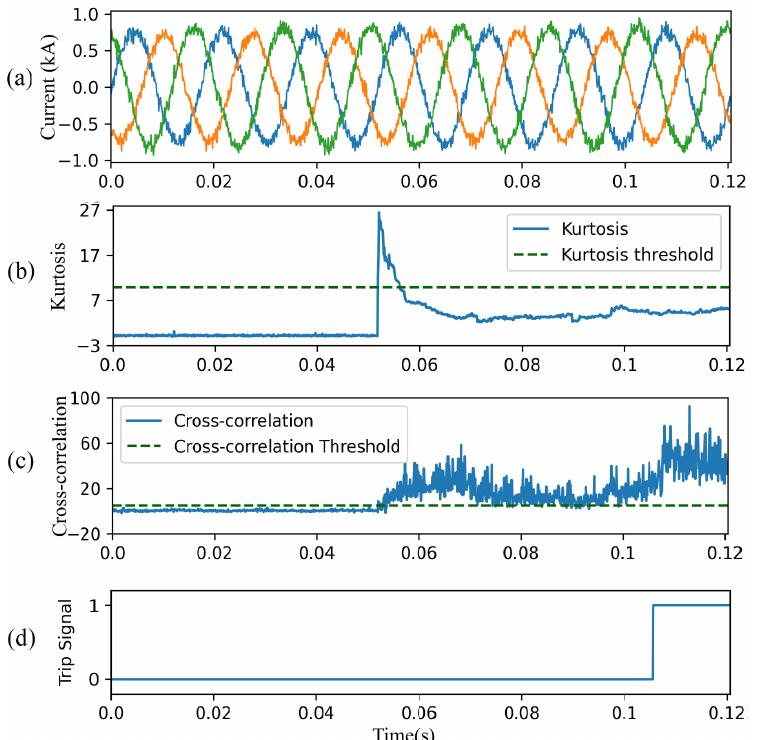
Figure 20. CAE-HIFD performance under 20 dB SNR: ( a ) three-phase input currents, ( b ) kurtosis, ( c ) cross-correlation, and ( d ) trip